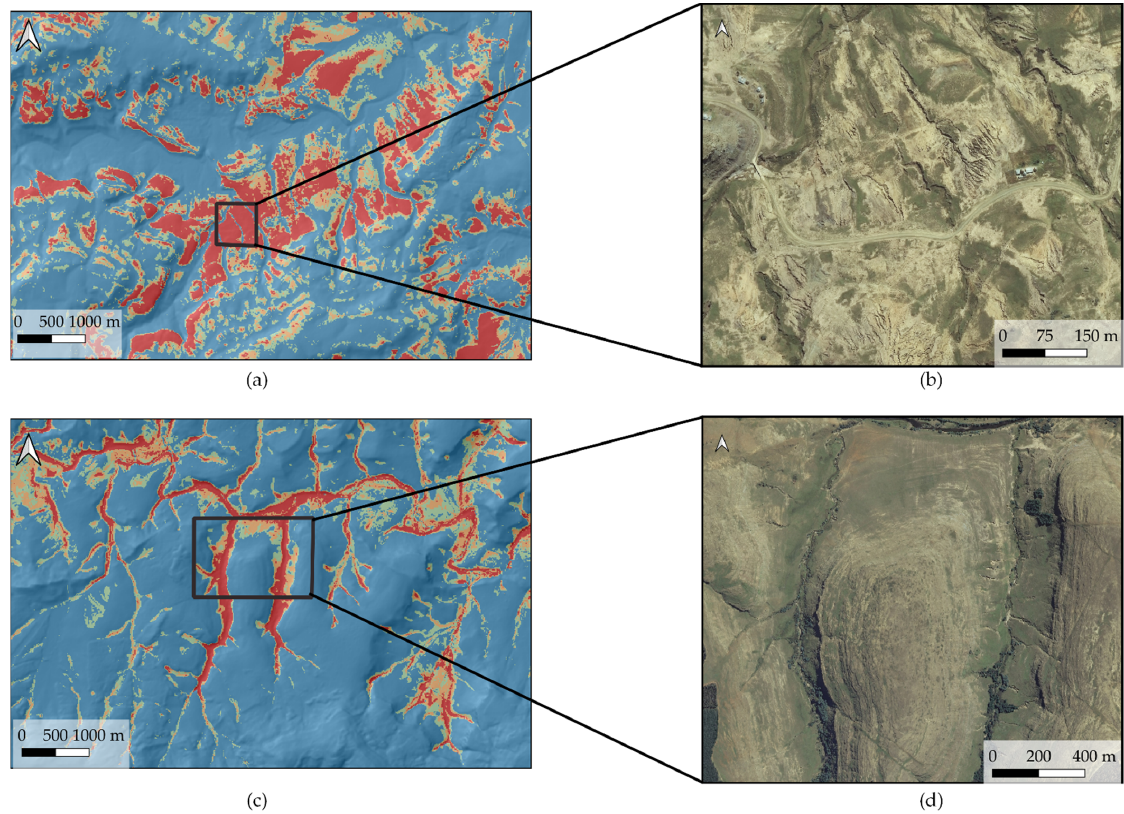
Figure 8. ( a , c ) Details of the susceptibility map. ( b , d ) gully type A and gully type B,